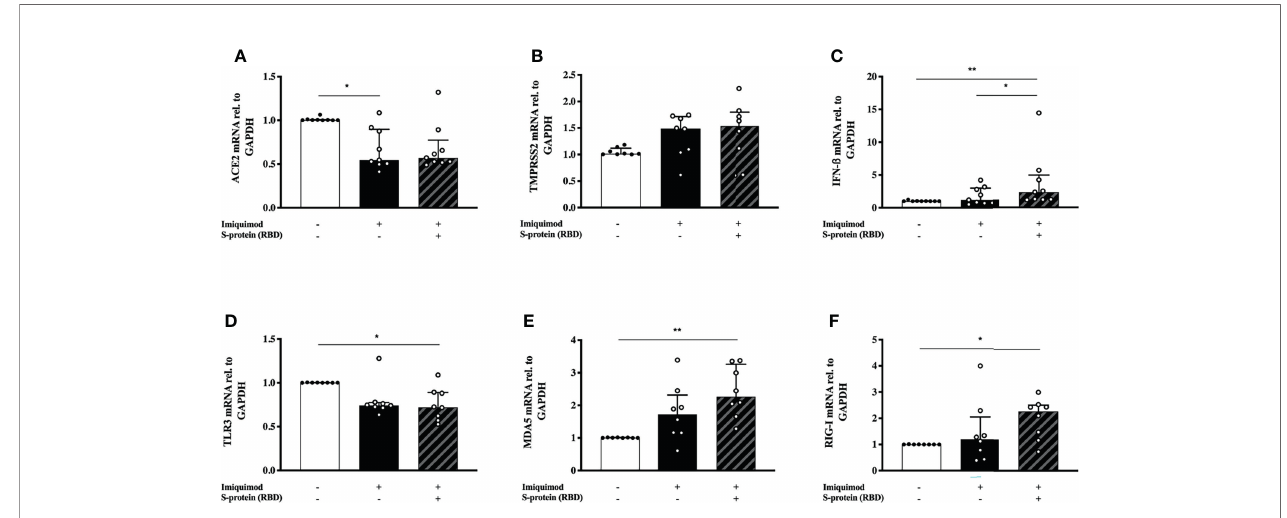
FIGURE 4 | S-protein 1 (SP1) from SARS-CoV-2 in combiantion with the anti-viral drug imiquimod decreases the expression of ACE2 receptor and increases the anti-viral response in human bronchial epithelial cells (HBECs) from asthma patients. mRNA expression of ACE2 (A) , TMPRSS2 (B) , IFN- b (C) , and the pattern recognition receptors TLR3 (D) , MDA5 (E) , and RIG-I (F) in HBECs from patients with asthma (study population 2; N = 8-9) in response to imiquimod treatment alone (black bars) or in combination with SP1 (striped bars). *p < 0.05, **p < 0.01, Friedman test followed by Dunn´s multiple comparison